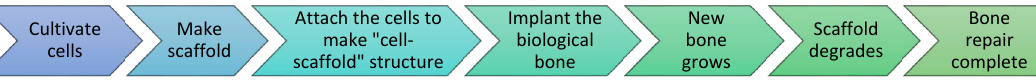
Figure 1. Bone tissue repairing process.